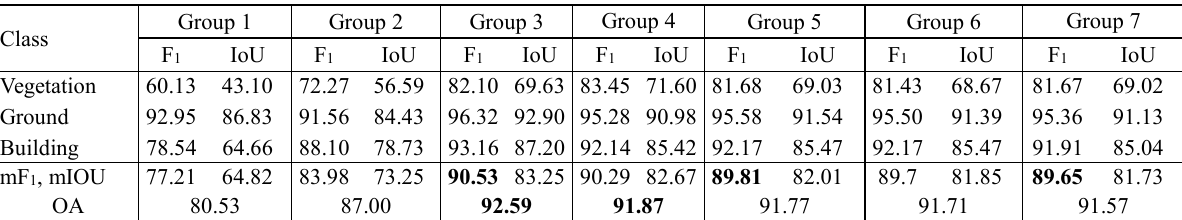
Table 3. Classification results (in percentage %) of the proposed algorithm for the AHN test data set. The performance metrics are F 1